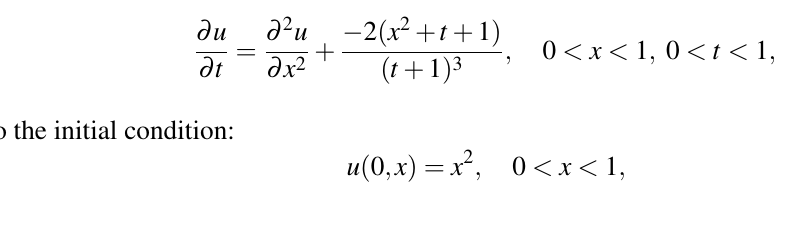
Table 3. L ∞ of Test Problem 4 for different numbers of collocation